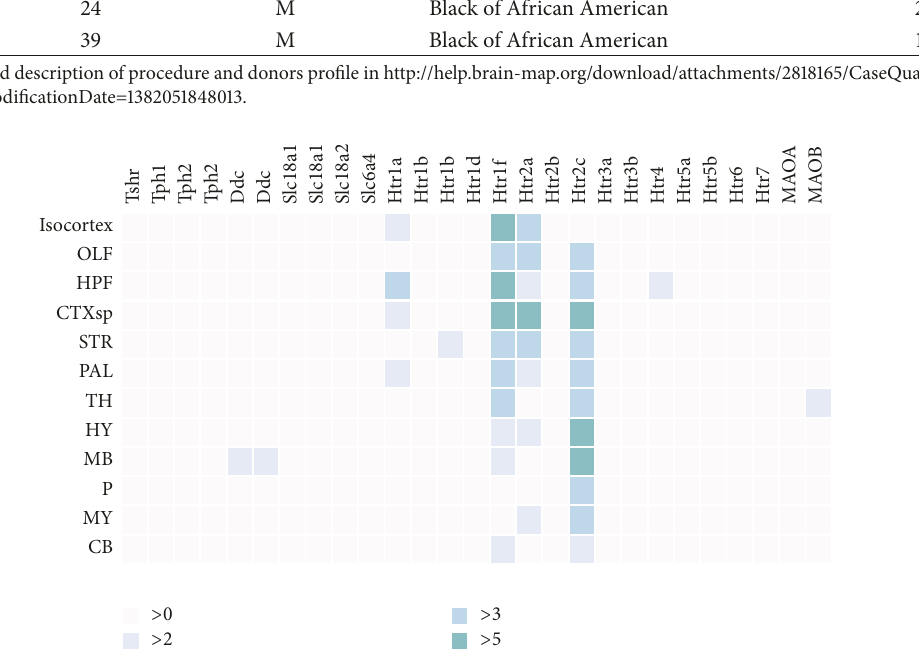
[VMAT-2]), and the pons, medulla and cerebellum with a sig- nificant presence of VMAT-2 and TPH-2 genes, also related to the synthesis and storage of 5-HT (Figure supplementary